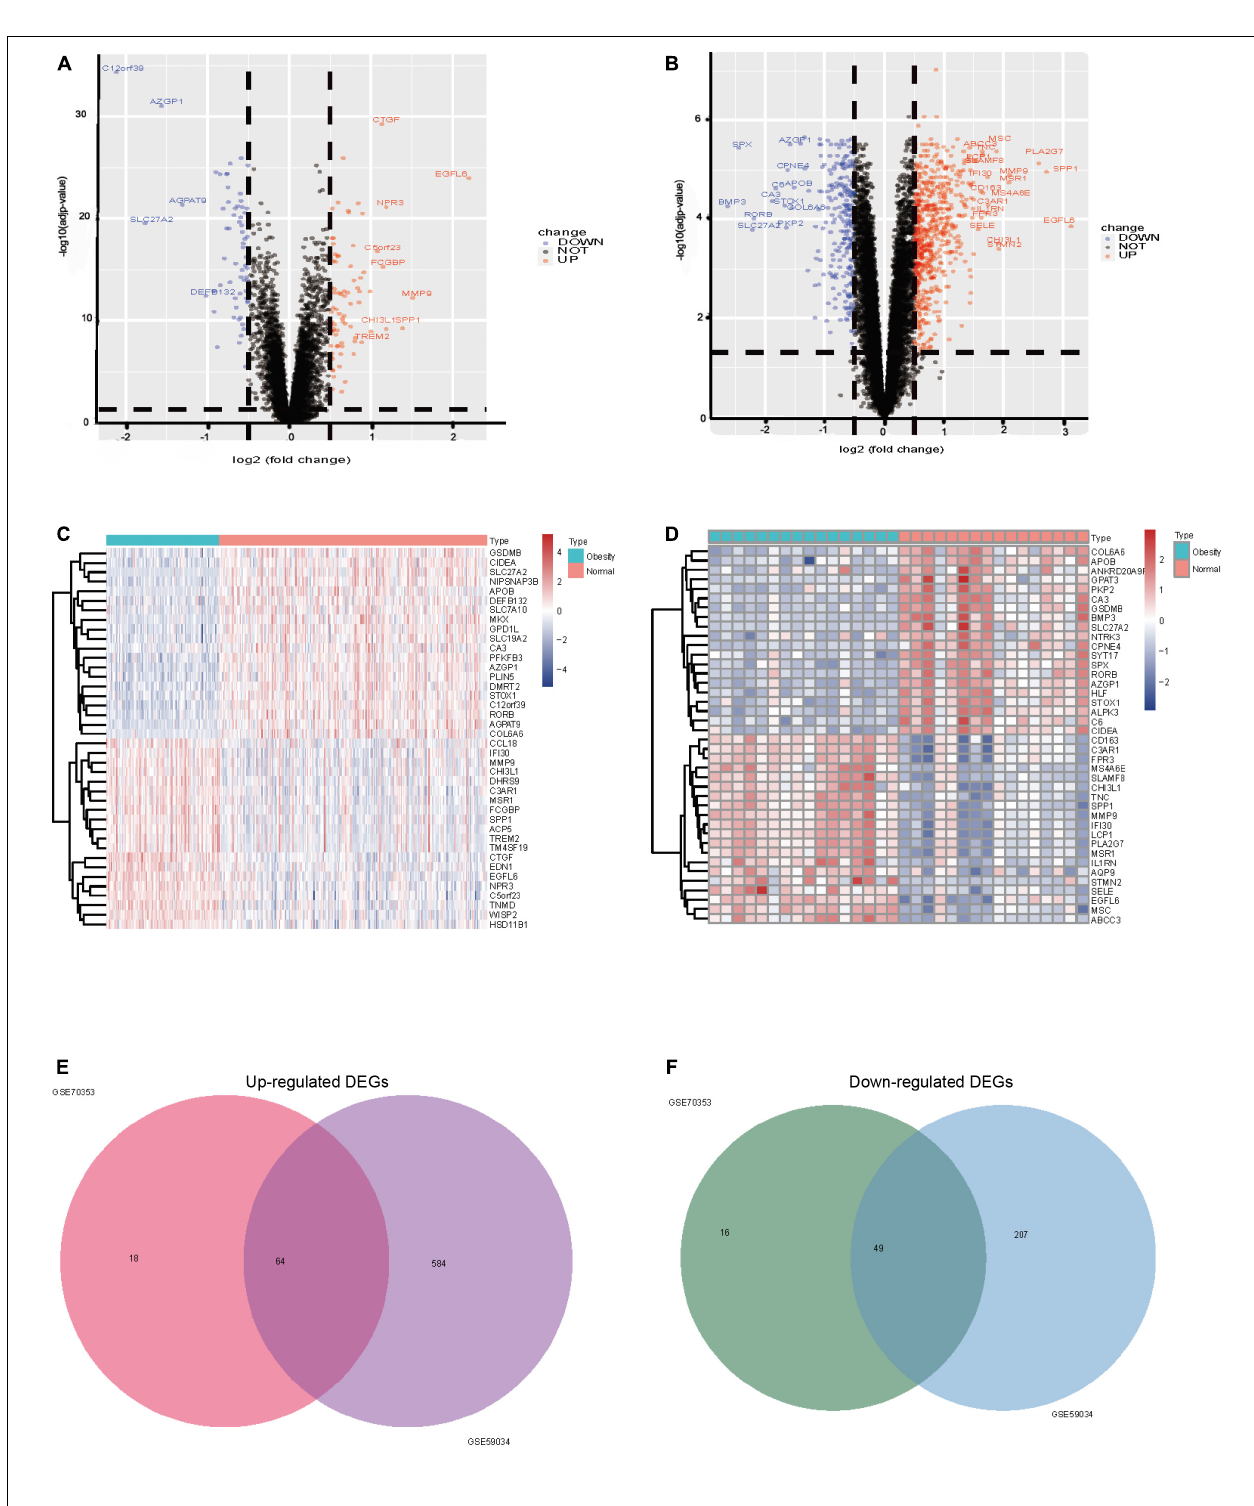
FIGURE 4 | (A) GSE70353 volcano plots of differentially expressed genes, 82 upregulated and 65 downregulated, Upregulated genes are marked in red, downregulated genes are marked in blue; (B) GSE59034 volcano plots of differentially expressed genes 648 were upregulated and 256 downregulated; (C) GSE70353 top 20 up and down expressed genes heatmap, Upregulated genes are marked in red, downregulated genes are marked in blue; (D) GSE59034 top 20 up and down expressed genes heatmap; (E) up-regulation of co-expression Venn map with 64 up-regulation; (F) down-regulation of co-expressive Venn map with a total of 49 down-regulation